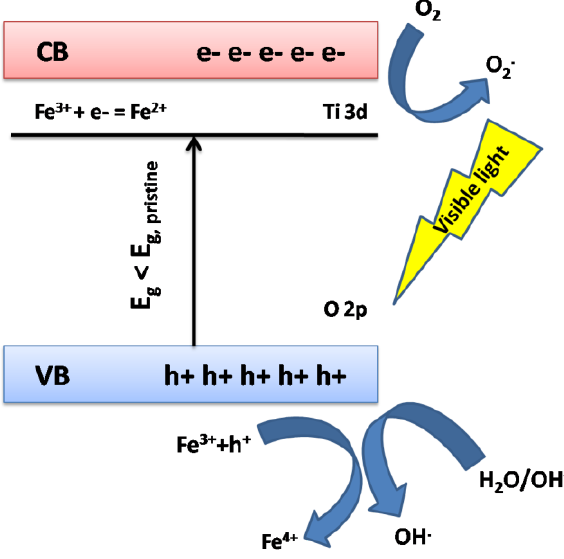
Figure 11. Schematic mechanism of visible light driven photocatalysis process Fe doped TiO 2 according to tailor the band gap.